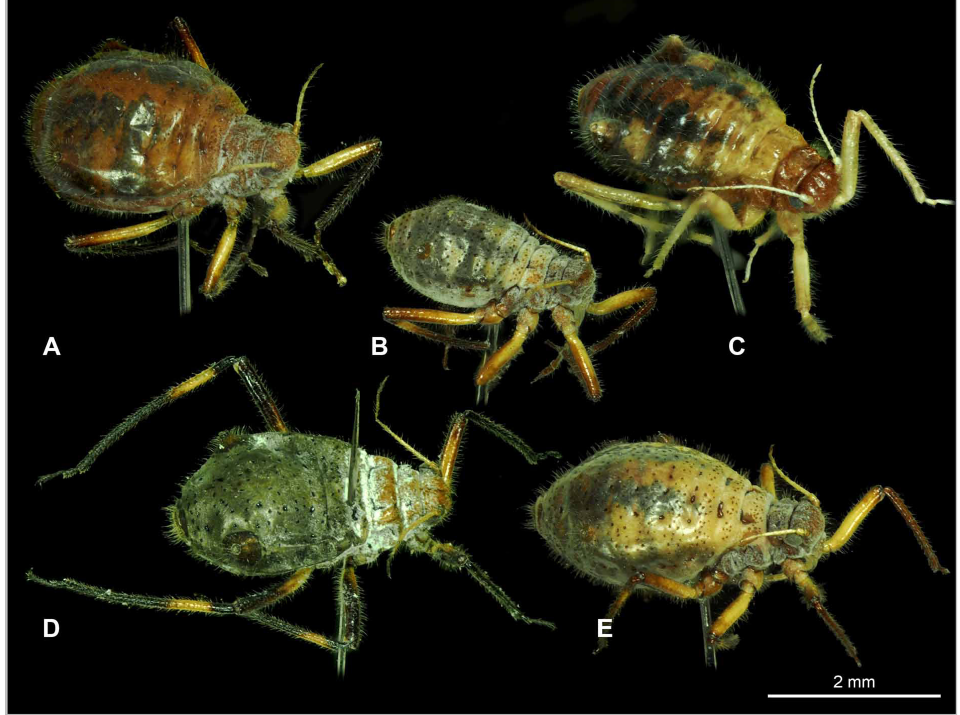
Fig. 103. Cinara (Cinara) pinea (Mordvilko, 1895). Freeze-dried specimens. A , C – D . Adult apterae. Teneral, appendages and hair-base sclerites still pale on C. B , E . Juvenile